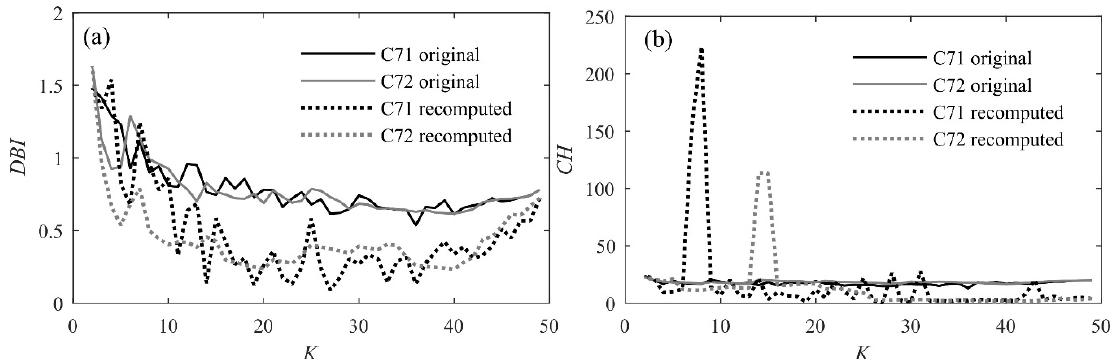
Figure 1. Comparison between original and recomputed CVIs for models C71 and C72 in terms of DBI ( a ) and CH ( b